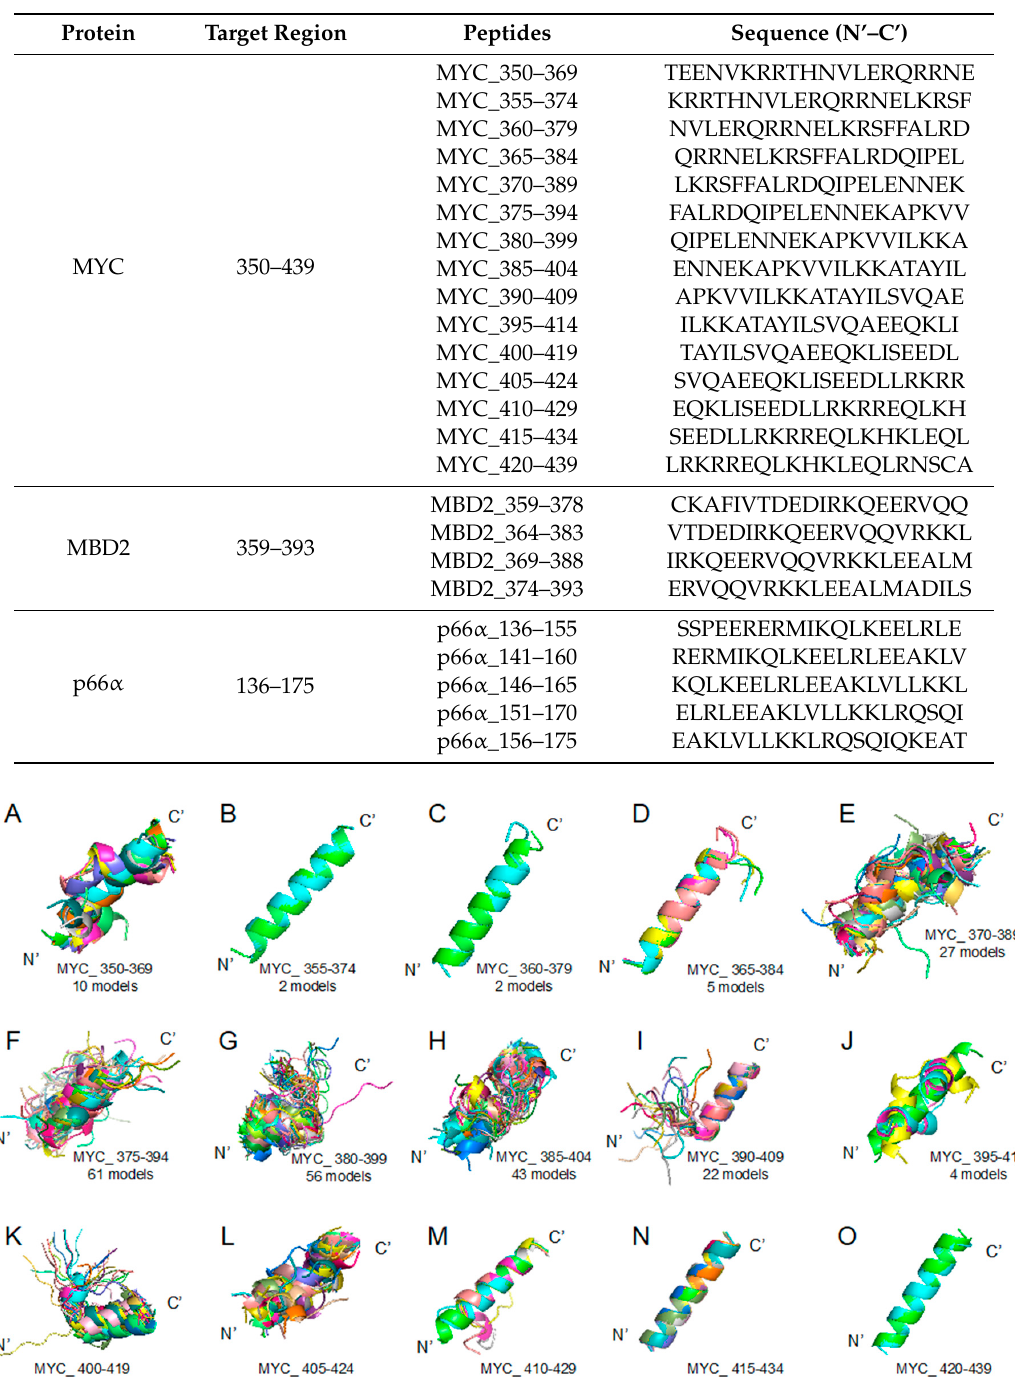
Table 1. Protein target regions and segmented peptides.